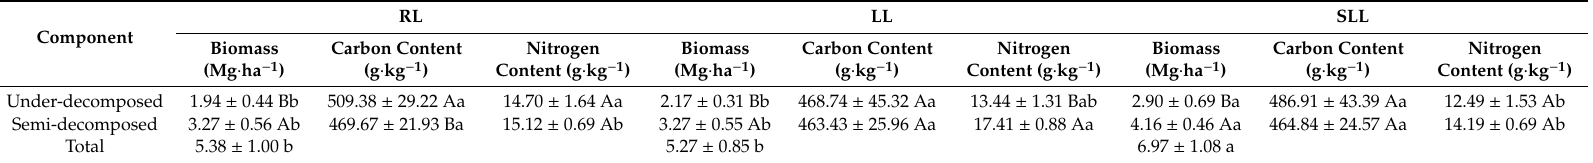
Table A2. Biomass, carbon and nitrogen contents in litter